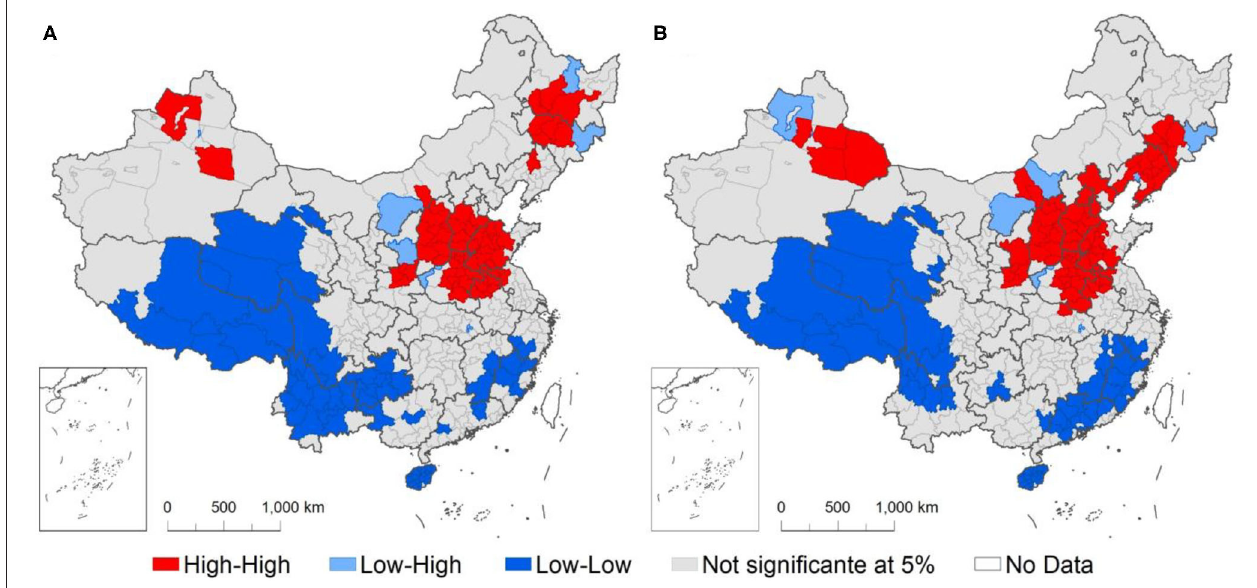
FIGURE 3 | The univariate Local Moran’s I for PM 2.5 concentrations in Chinese cities before (A) and after (B) lockdown measures were taken in response to the outbreak of COVID-19.